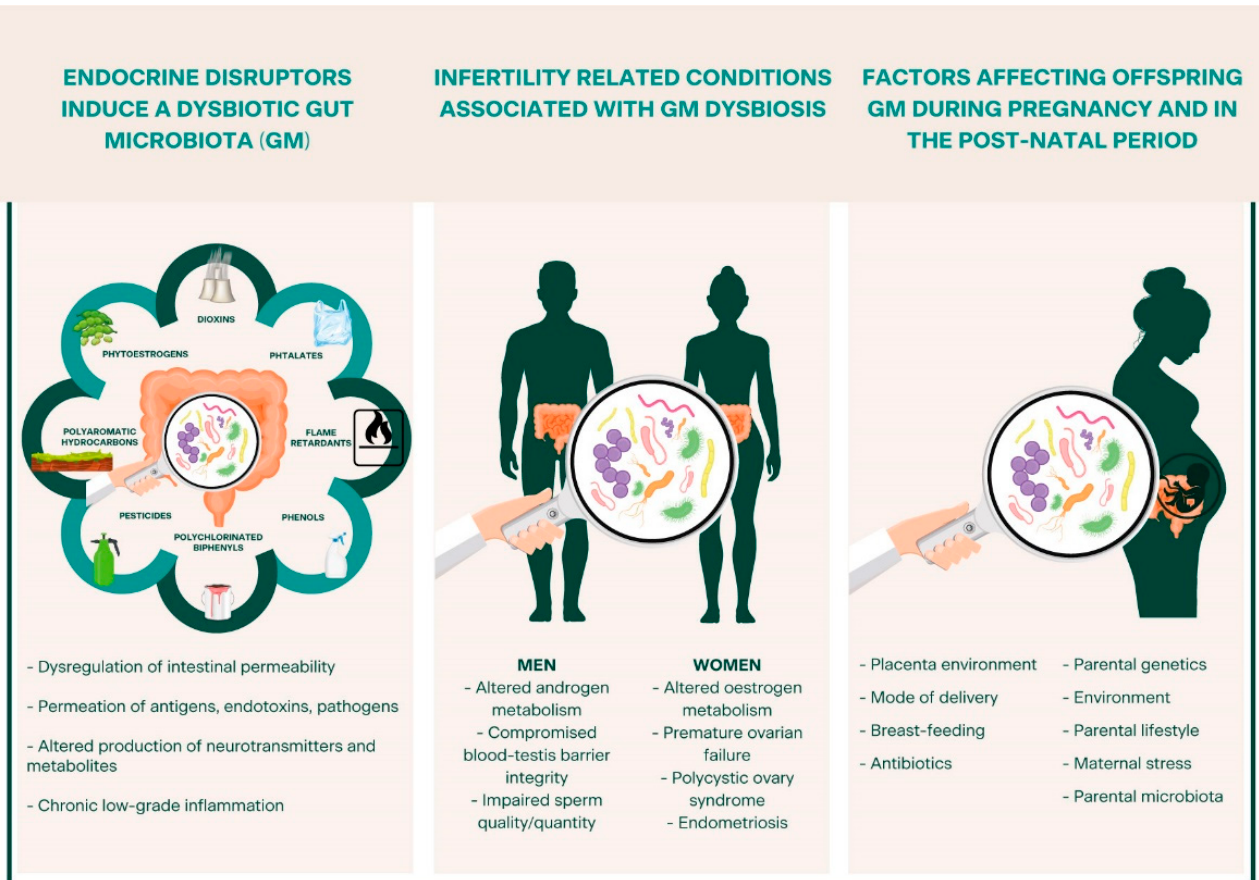
Figure 1. Overview of the intricate relationship among endocrine-disrupting chemicals (EDCs), gut microbiota (GM), and reproductive health. EDCs induce GM damage through several mechanisms of action, leading to GM dysbiosis, intestinal permeability, and chronic low-grade inflammation, conditions linked to several diseases, including those related to infertility. When a dysbiotic condition occurs during pregnancy or in the early post-natal period, it may lead to even worse detrimental effects, affecting both the acquisition and constitution of a healthy GM, with subsequent implications on the exposed individual, the offspring’s health, and reproductive